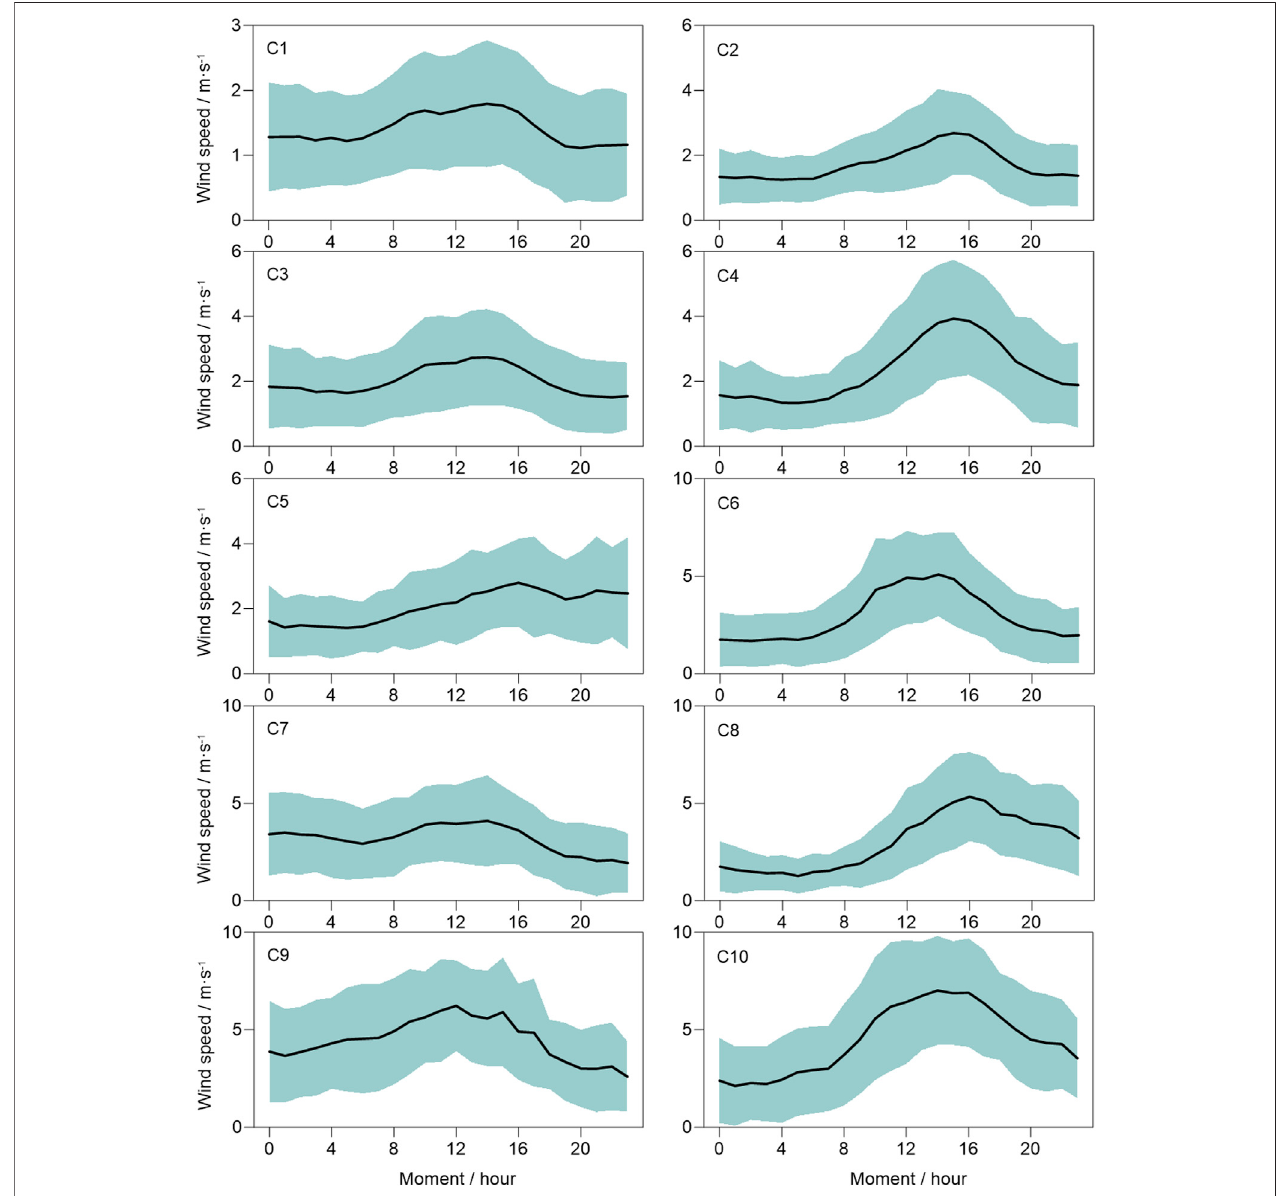
FIGURE 4 | The cluster analysis results of the hourly wind speed in 3,650 days at Shunyi station in Beijing. The X -axis is 00:00 – 23:00 CST, the Y -axis is the wind speed, and C1 – C10 represent the 10 clusters, respectively. The black line represents the sample average at different times, and the shade represents one standard deviation of the corresponding